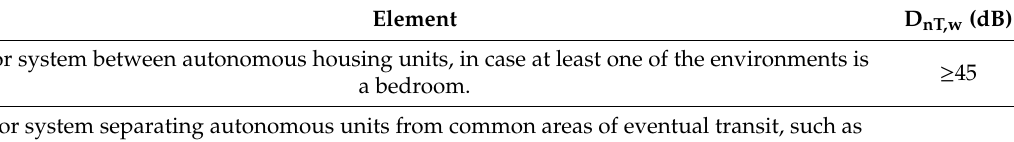
Table 4. Weighted standardized level di ff erence, D nT , w , for floor systems [15]. Element D nT,w (dB)